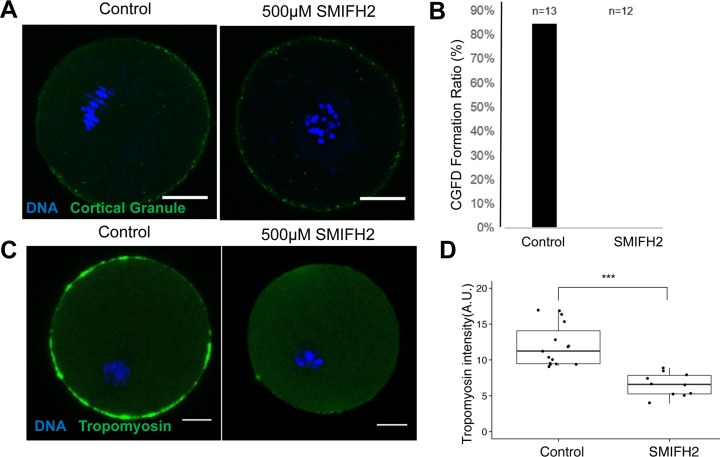
Treatment with SMIFH2 ablates formation of the cortical granule free domain (CGFD) and decreases the cortical tropomyosin levels.
A. Treatment with SMIFH2 impairs the formation of the cortical granule-free domain (CGFD) in comparison to control oocytes (left). Oocytes treated with 500 μM of SMIFH2 failed to form the CGFD, which is stained with labeled lectin (green). Chromatin was visualized with Hoechst 33342 (blue). Bar: 20 μm. B. CGFD formation (%) in control oocytes (n = 13) and in oocytes treated with 500 μM of SMIFH2 (n = 12). C. Treatment with SMIFH2 affects the cortical tropomyosin levels. In control oocytes (left) and oocytes treated with 500 μM of SMIFH2, Tpm3-2 in cortical actin was immunostained (green) and DNA was stained with Hoechst 33342 (blue). Bar: 20 μm. D. Intensity of the cortical tropomyosin in control oocytes (n = 17) and in oocytes treated with 500 μM of SMIFH2 (n = 10). The box represents the interquartile range; the whiskers show 1.5x the interquartile range; line inside the box represents the median.